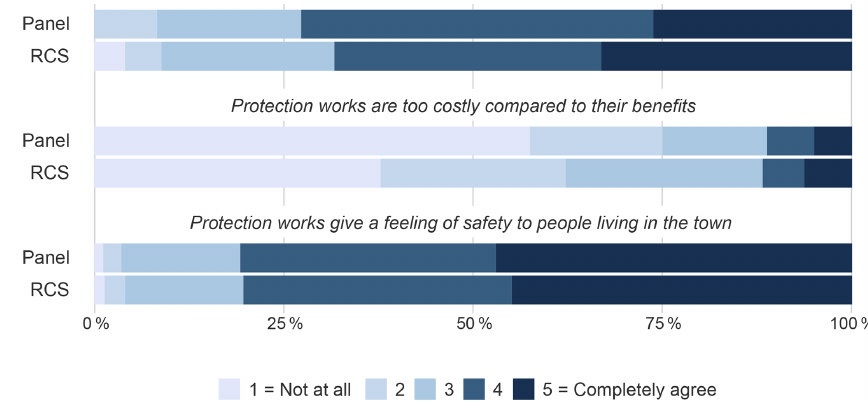
Figure 2. Survey results from the second round on public structural flood protection undertaken by the